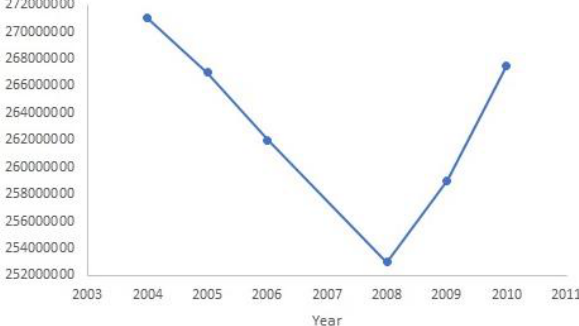
Fig. 3. Total volume of water sold by the local water company in Jakarta